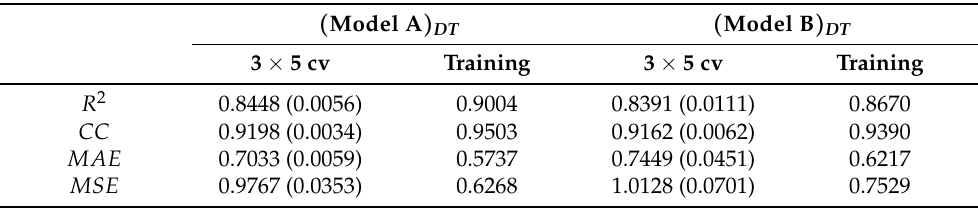
Table 4. Decision Tree results. Values (mean and standard deviation) of the different measures when using a 3 × 5-fold cross-validation and when using the whole dataset as training are